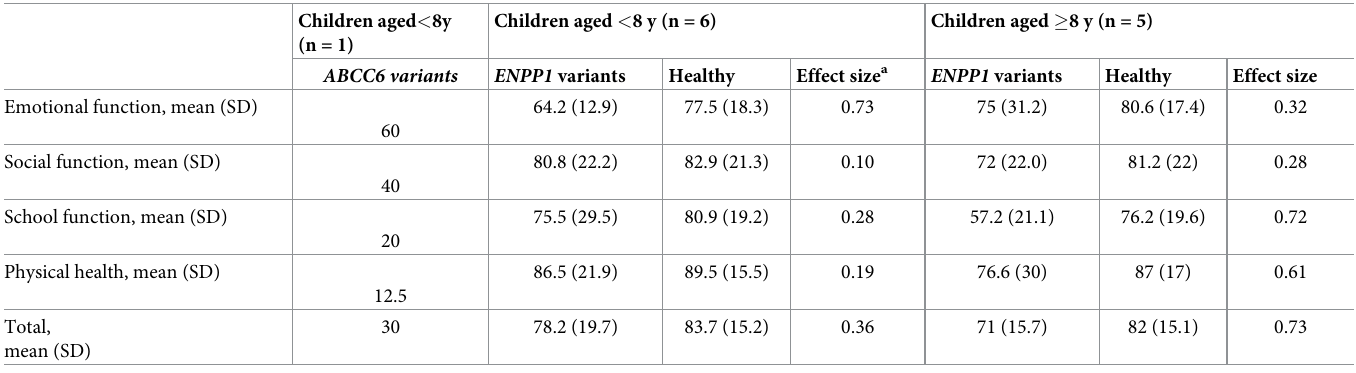
Table 2. PedsQL scores for children With ENPP1 Deficiency and infant onset ABCC6 Deficiency vs healthy children. Children aged < 8y (n =